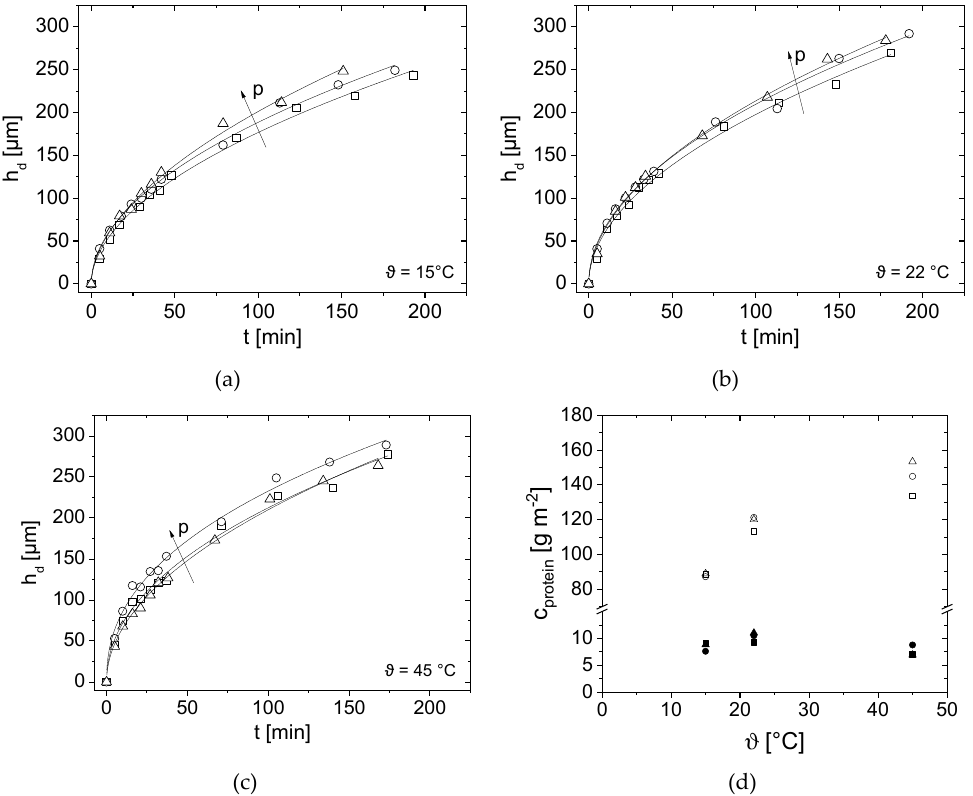
Figure 6. Deposit height h d at z = 29 cm as a function of filtration time t for ( a ) ϑ = 15 °C ( b ) ϑ = 22 °C and ( c ) ϑ = 45 °C. A small difference in deposit height was observed especially at large filtration times for p = 0.25 bar (squares), p = 0.75 bar (circles) and p = 1.25 bar (triangles). The deposit height was empirically modelled by h d ( t ) ∝ t b ,local (lines). ( d ) Protein concentration c protein on the membrane surface as a function of filtration temperature ϑ for p = 0.25 bar (squares), p = 0.75 bar (circles) and p = 1.25 bar (triangles). Open symbols represent caseins and closed whey proteins.